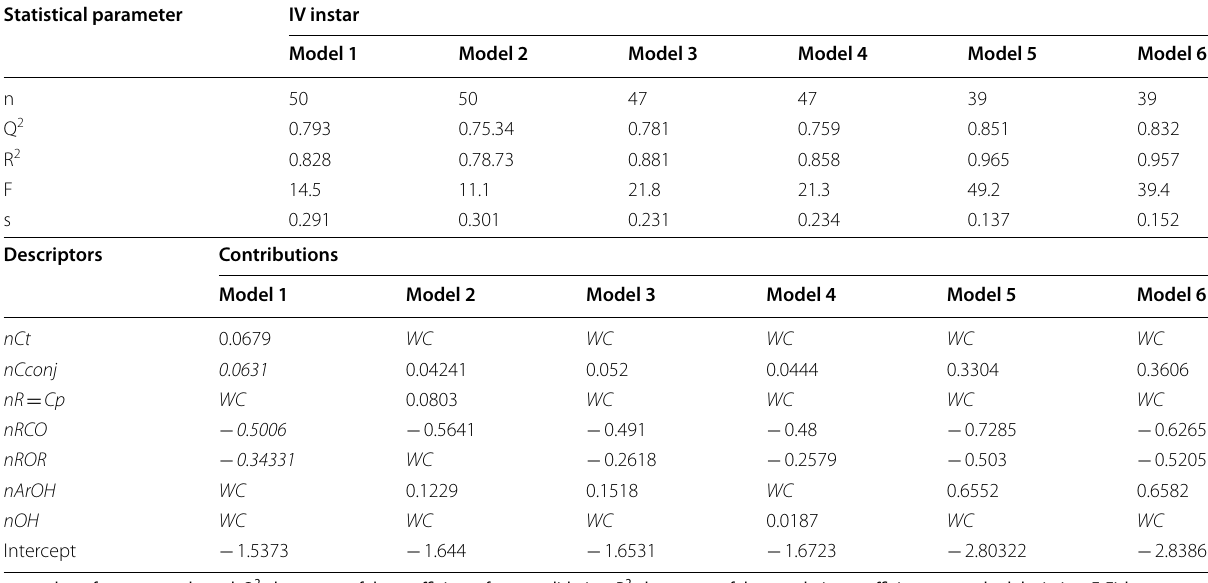
n, number of systems evaluated; Q 2 , the square of the coefficient of cross‑validation; R 2 , the square of the correlation coefficient; s, standard deviation; F, Fisher statistic; WC , without contribution; nCt , number of total tertiary C (sp 3 ); nCconj , number of non‑aromatic conjugated C (sp 2 ); nR